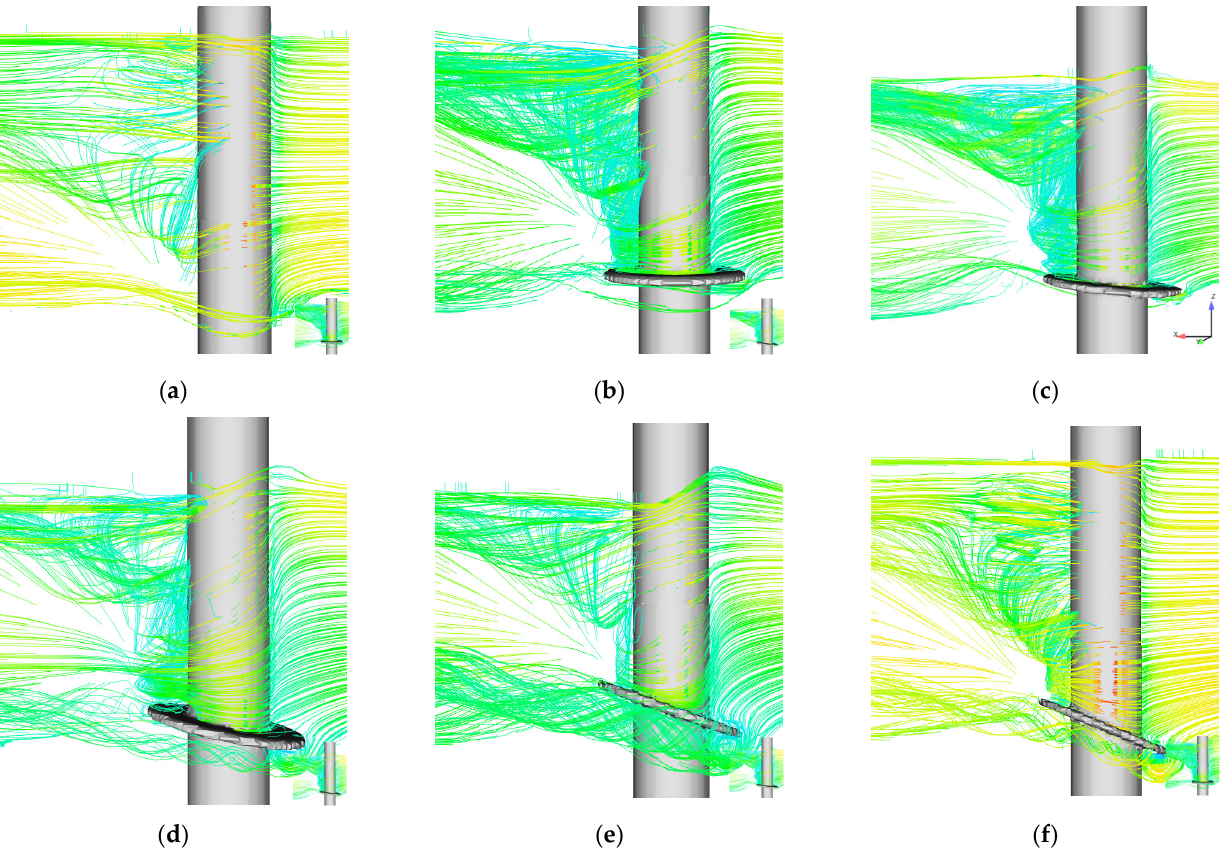
Figure 12. The streamline (colored by the velocity) at y = 0.15 m and t = 400 s of each case. ( a ) Case 1 (without circular collar). ( b ) Case 2 (θ = 0°). ( c ) Case 3 (θ = 5°). ( d ) Case 4 (θ = 10°). ( e ) Case 5 (θ = 15°). ( f ) Case 6 (θ = 20°).